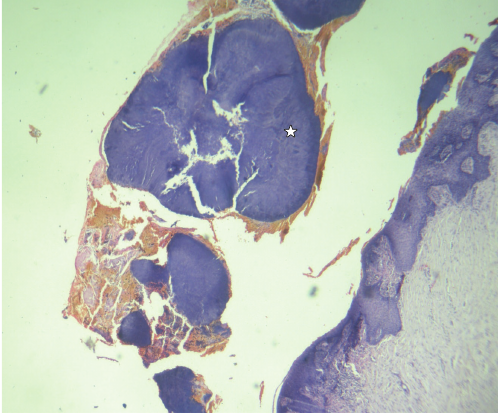
Figure 6: Photomicrograph (10x) of H&E decalcified section. Necrotic thickened bony trabeculae with Actinomyces filaments on trabecular surface of bony spicules ( f ), with extensive sclerosis of bone showing prominent resting and reversal lines ( ff ).